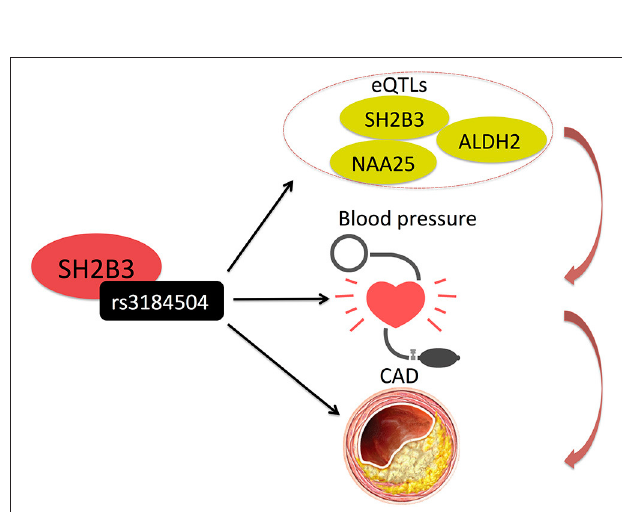
FIGURE 4 | Huan et al. (30) uncovered a blood pressure associated SNP (rs3184504) in SH2B3, which also associates with the expression (eQTL) of several genes, including SH2B3 itself, in the genetically inferred causal blood pressure gene sets. Rs3184504 has been previously also associated with CAD risk. (9) Black arrows indicate association findings. Red arrows indicate the presumed functional cascade leading to CAD.